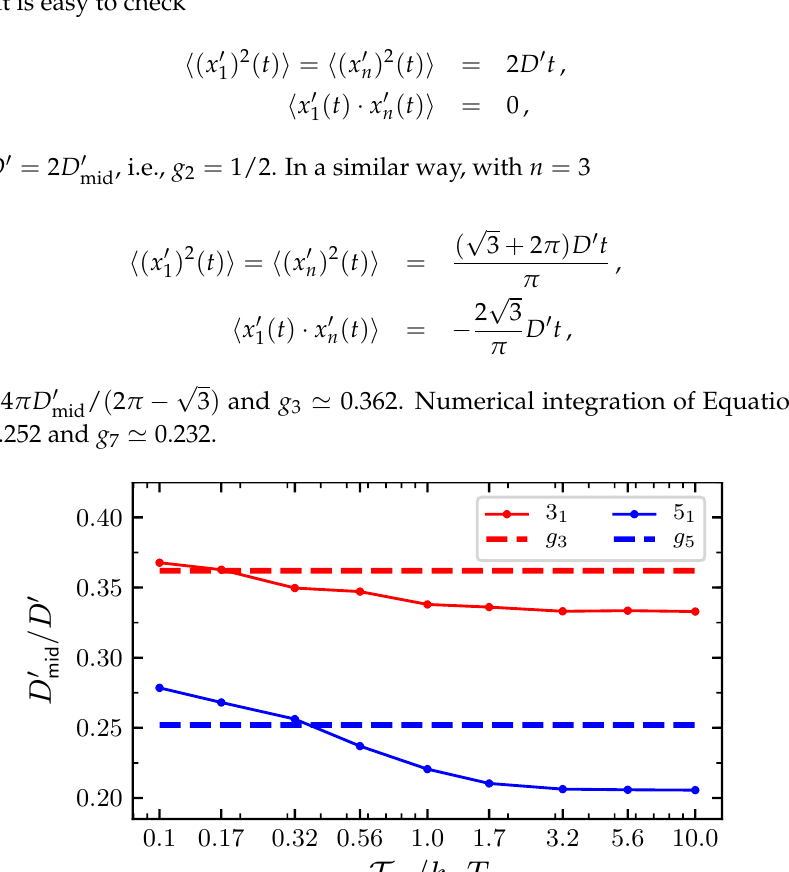
for the middle position of n k particles satisfying mid / D (cid:48) as a function of the pulling force mid